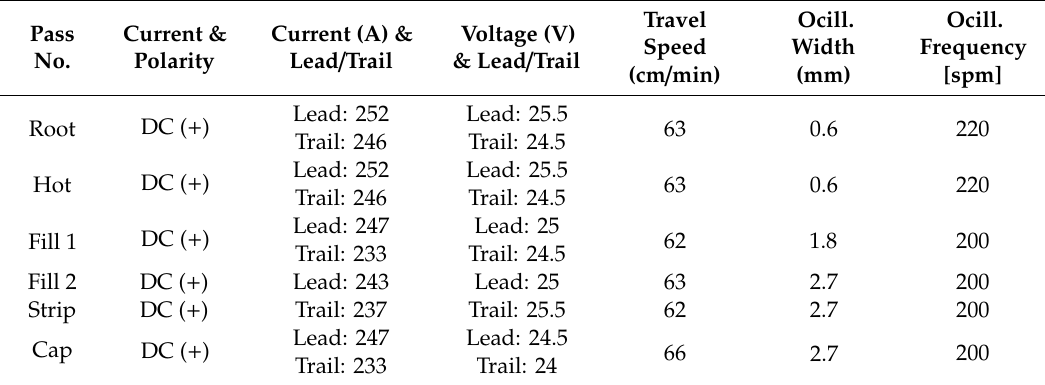
Figure 16. Schematic of U-groove shape without root gap: ( a ) Joint detail and ( b ) welding sequence.